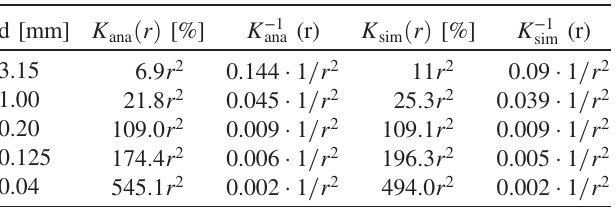
TABLE I. Analytical and simulated effect of the 3 He propor- tional counter distance on the efficiency and attenuation.